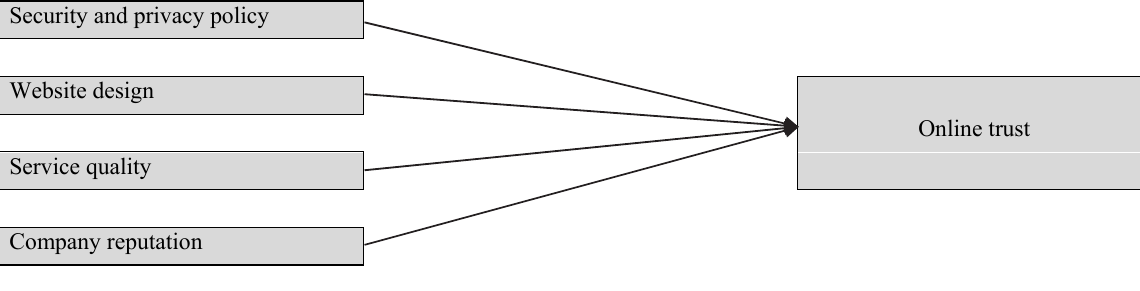
Fig. 1. Theoretical